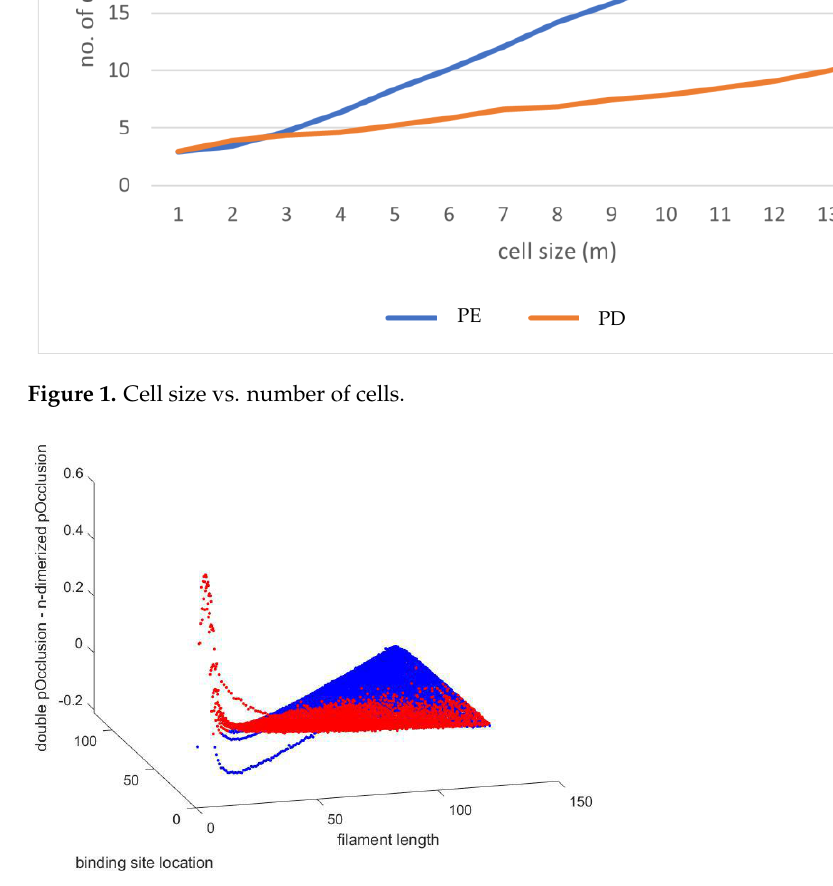
Figure 2. Variation in torque with time of HDPE-HA composites during mixing.